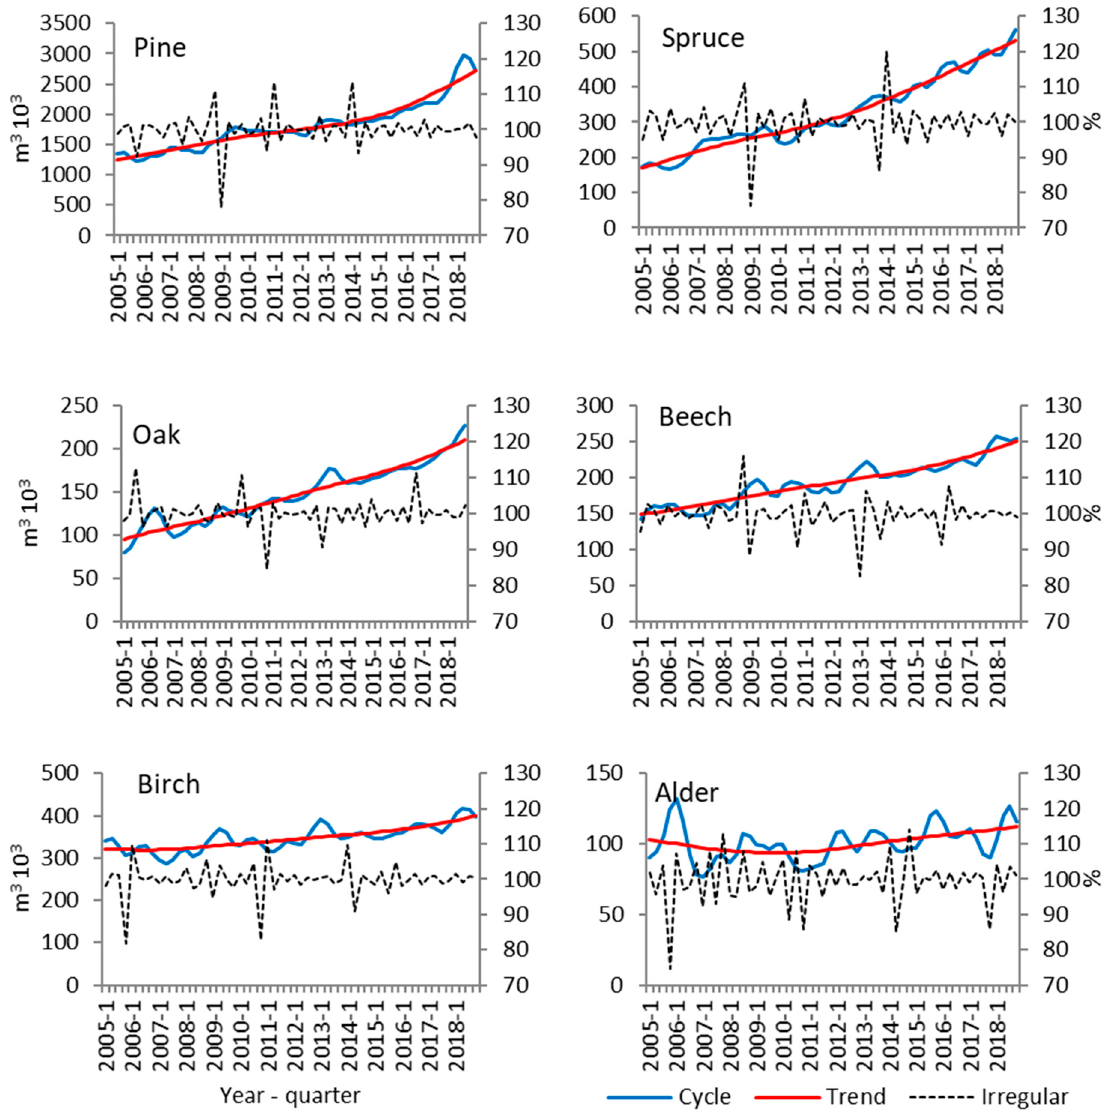
Figure 6. Irregular and cyclical fluctuations and the long-term trend of S2A timber supply in Poland in the years 2005–2018.